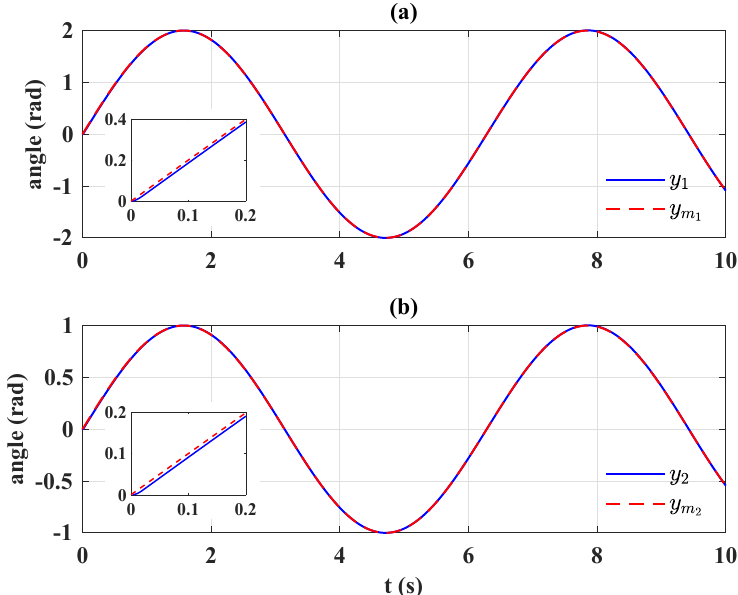
Figure 1. Time history of system outputs and references ( a ) y 1 , y m